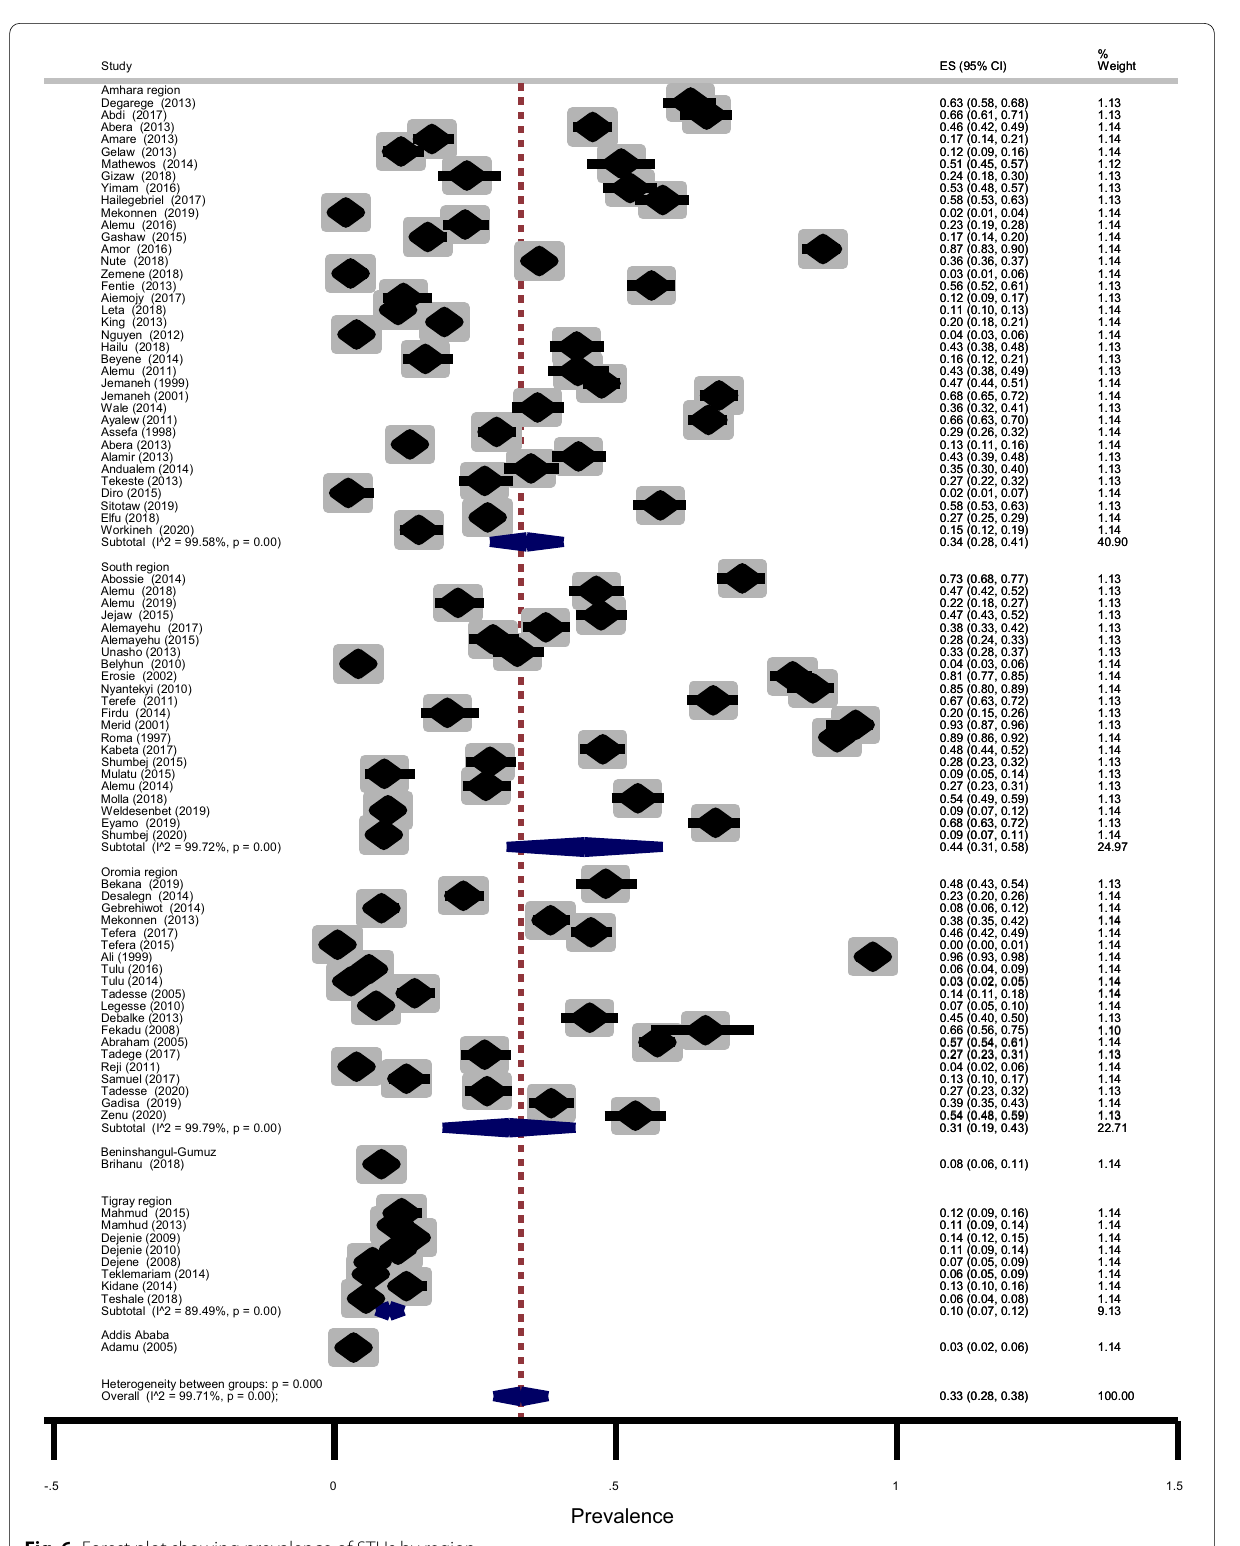
Fig. 6 Forest plot showing prevalence of STHs by